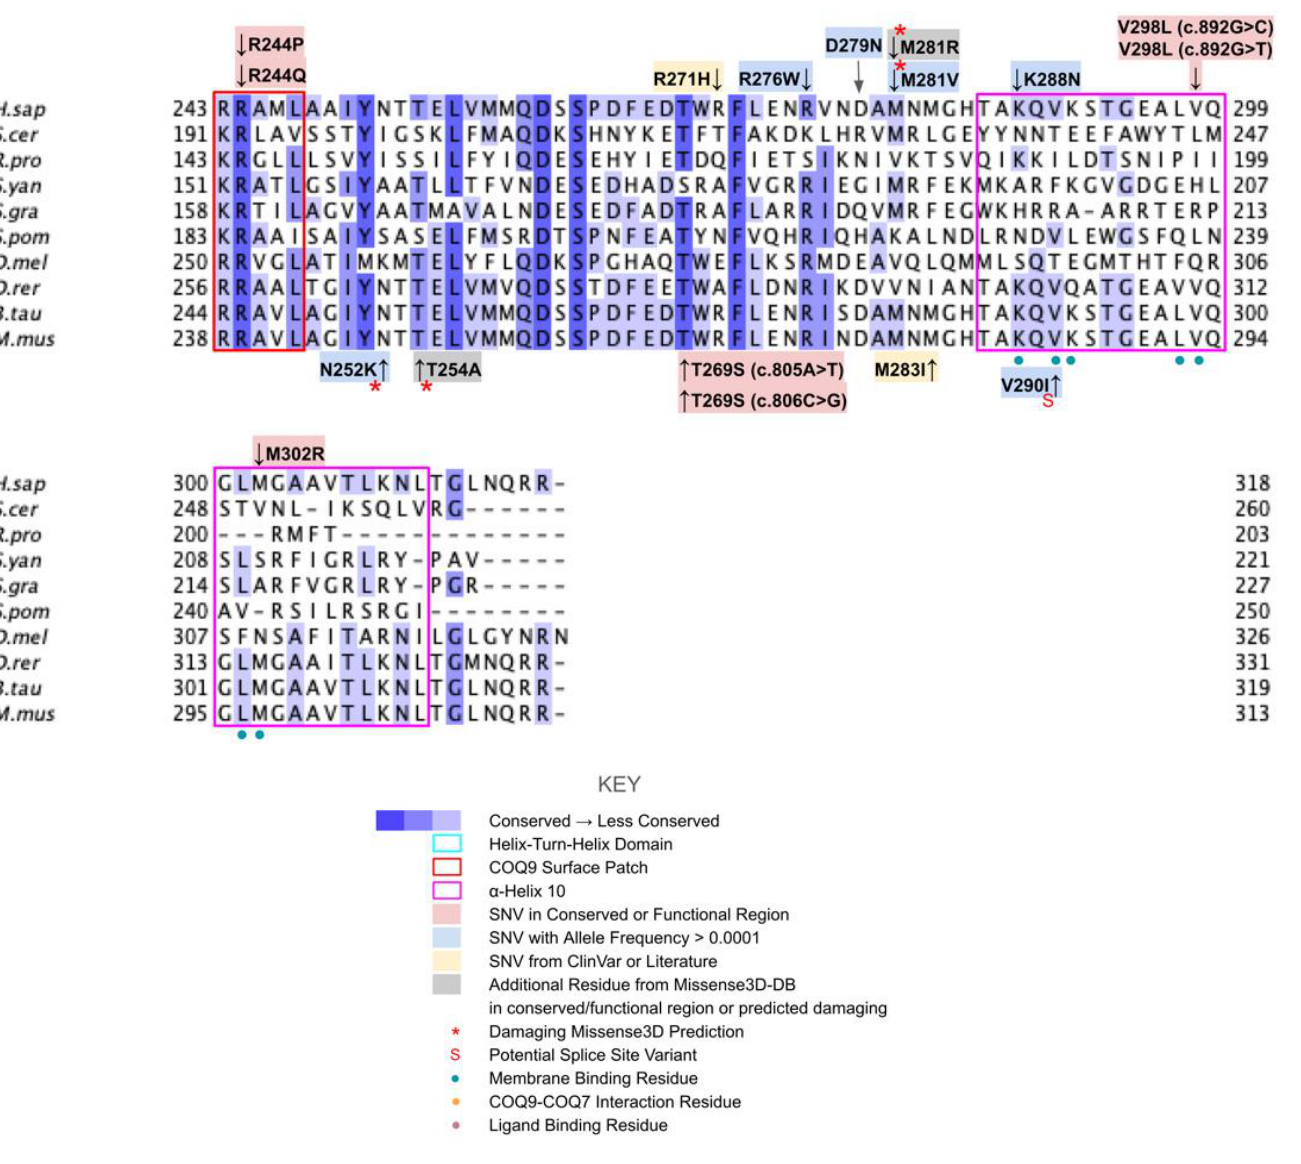
Figure 28. Labeled and annotated multiple sequence alignment of COQ9. Amino acid sequences of COQ7 were analyzed as described in Materials and Methods and include Homo sapiens (NCBI accession number NP_064708.1) and homologs in Saccharomyces cerevisiae (QHB10353.1), Rickettsia prowazekii (WP_004596292.1) , Sphingomonas yanoikuyae (EKU74250.1) , Sphingopyxis granuli (WP_082737038.1) , Schizosaccharomyces pombe (NP_594426.1), Drosophila melanogaster (NP_724594.1), Danio rerio (NP_001092216.1), Bos taurus (NP_001039767.1), and Mus musculus (NP_080728.1). See KEY for descriptions of the figure annotations. Residues in the HTH domain are boxed in cyan and COQ9 surface patch in red, data from [25]. COQ7 interaction residues are marked with orange dots, data from [52]. Ligand-binding residues are marked with purple dots, data from [50].